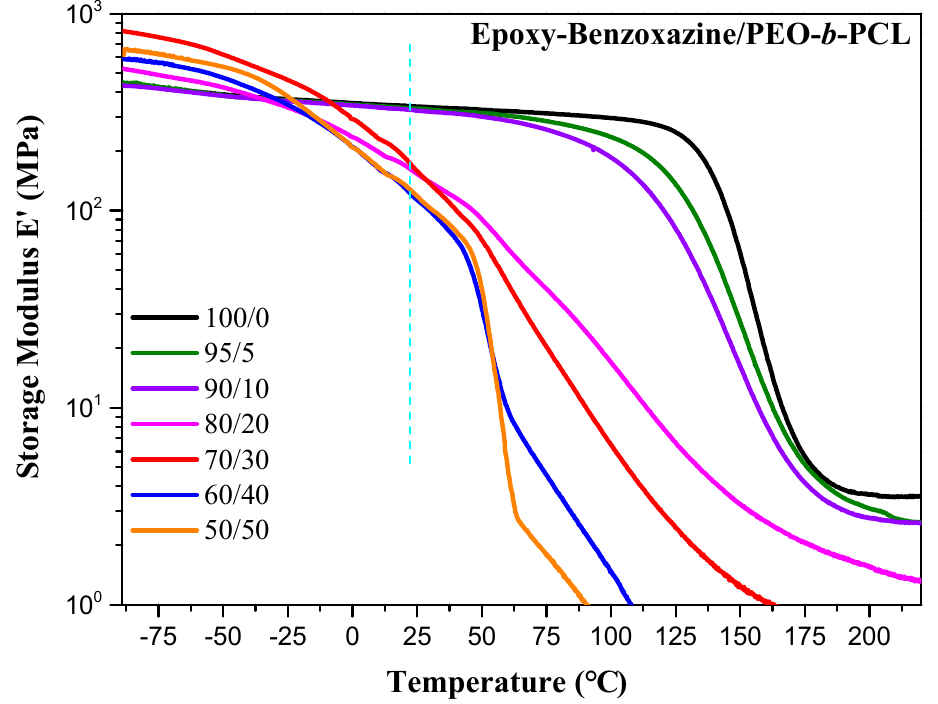
Figure 9. DMA storage modulus curve of epoxy–benzoxazine/PEO ‐ b ‐ PCL blends (heating rate: 2 °C ∙ min –1